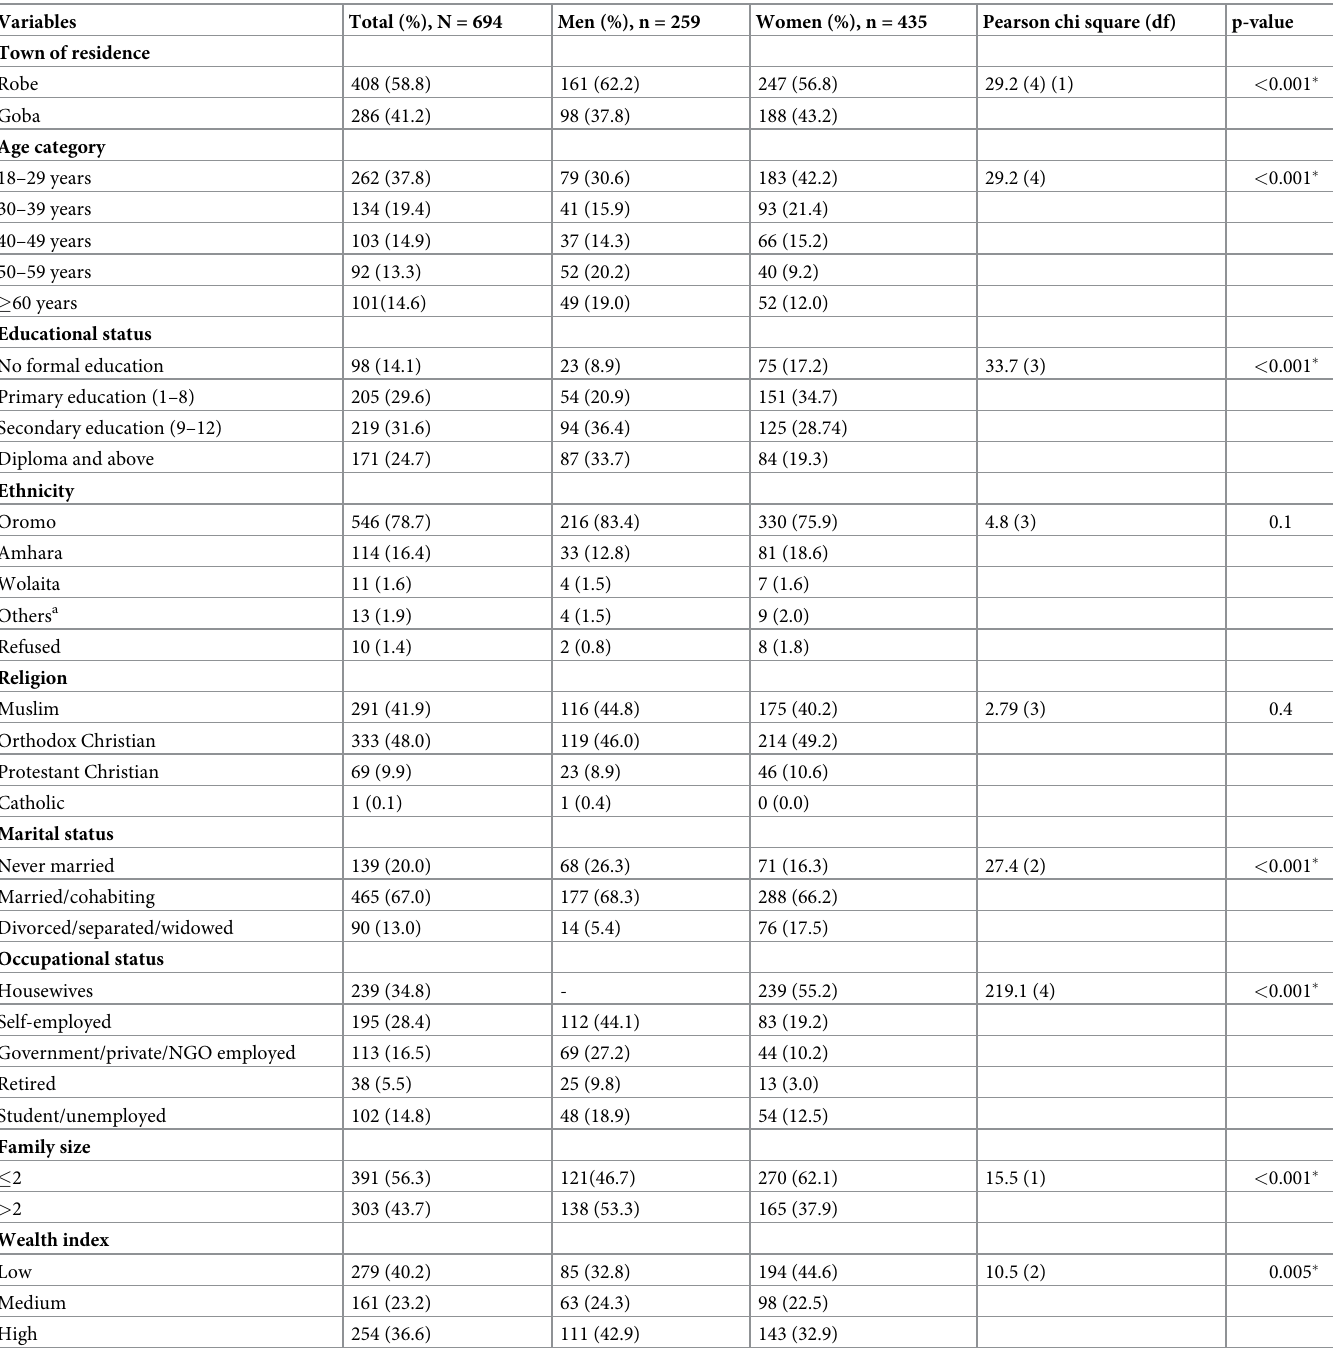
Table 1. Sociodemographic characteristics of study participants in administrative towns of Bale Zone, Southeast Ethiopia,